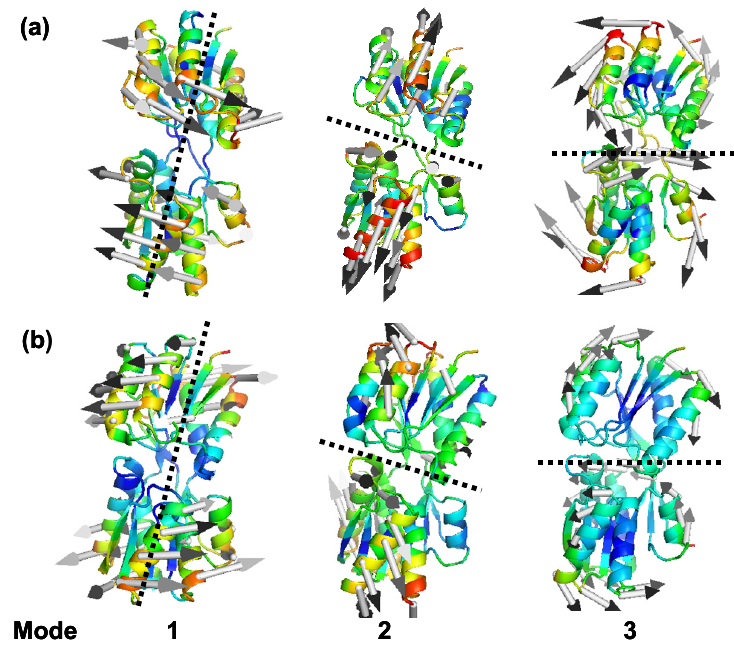
Figure 5. Mean-square fluctuations of the three slowest Anisotropic Network Model (ANM) modes are color mapped on to the ( a ) open and ( b ) closed conformations of RBP. Two structures have the similar motion status in the three slowest ANM modes. The longitudinal and transverse axes are shown with the dashed black lines in the figures, which represents the hinge rotation axis. Mode 1 is a rotation motion of the two domains around the hinge rotation axis. In the mode 2, the two domains open and close with respect to each other. In the mode 3, the two domains make a twisting motion. The arrows indicate the direction of fluctuations. The figures were generated using the program